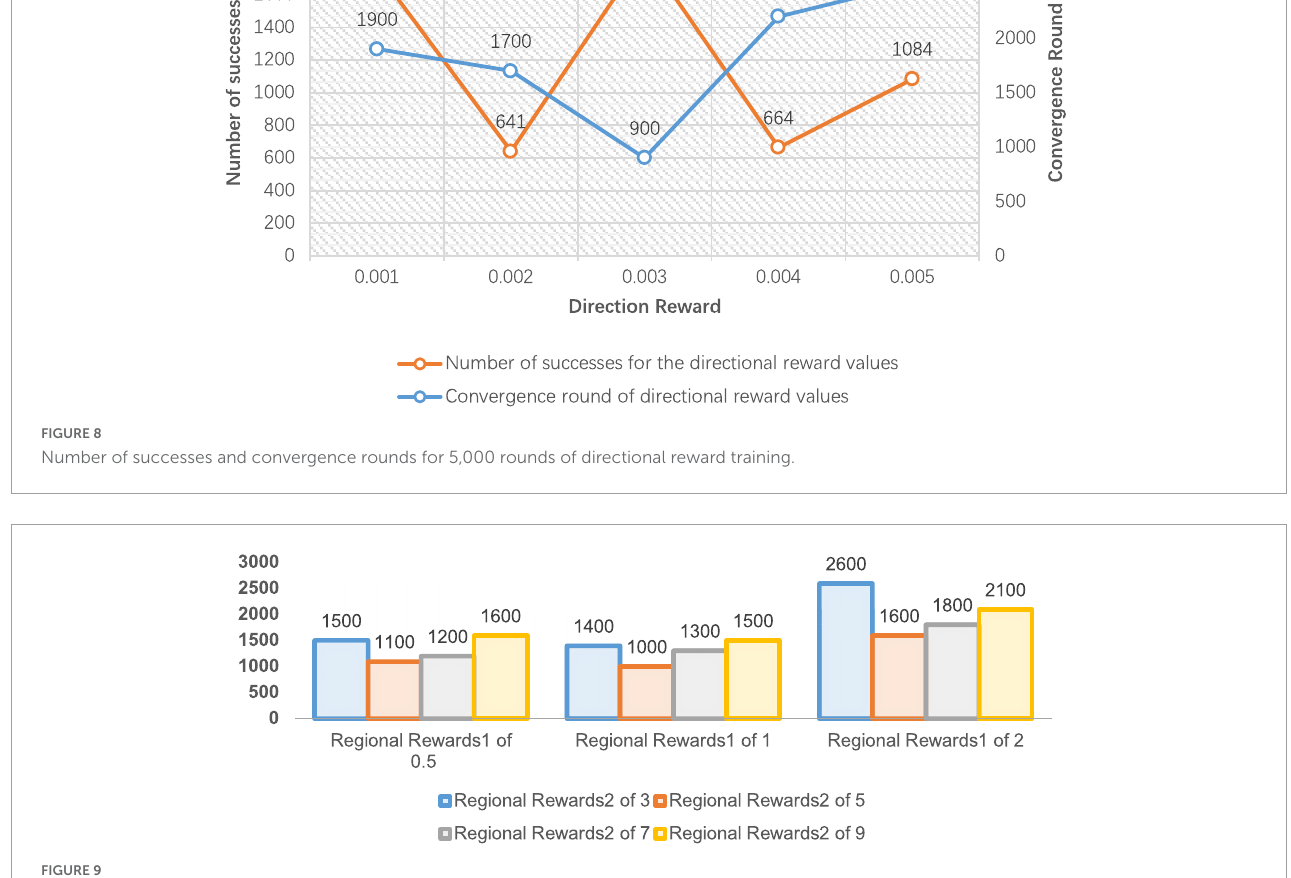
FIGURE9 Convergence rounds for 5,000 rounds of regional reward